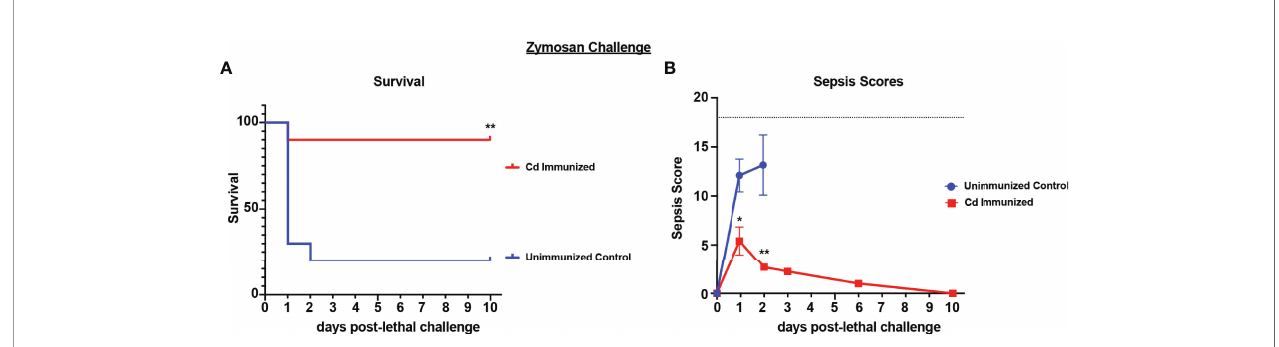
FIGURE 3 | Immunization with Candida dubliniensis induces protection against zymosan-induced sepsis. Mice (n=10/group) were given 1.75x10 7 CFUs of live C. dubliniensis (strain Wü284), i.p. as an immunization followed by challenge with lethal 700-1000 mg/kg zymosan and monitored for (A) survival and (B) morbidity following lethal challenge for 10 days. Animals receiving no primary challenge served as the negative (lethal) control. Mice were monitored for survival and morbidity/ sepsis scoring for 10days post-lethal challenge. Naïve (unvaccinated) mice served as the negative control. Graphs are representative of 3 separate experiments. *, P<0.05; **, P<0.01; ***, P<0.001; ****, P<0.0001 [for values signi fi cantly different from those of the unvaccinated control, by log rank Mantel-Cox (survival) and ANOVA followed by post hoc Student ’ s t-test (sepsis scoring)].